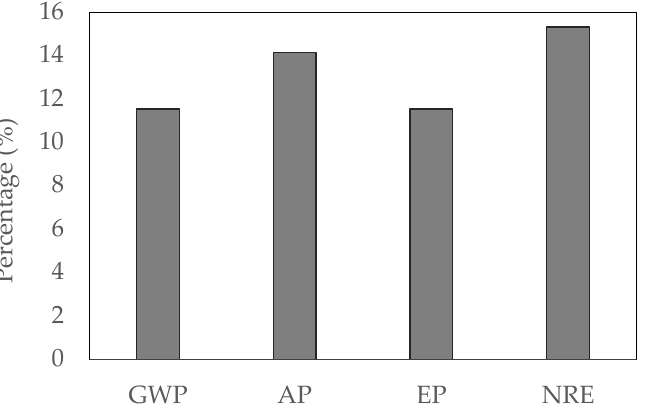
Figure 5. Average possible reductions for GWP (Global Warming Potential), AP (Acidification Potential), EP (Eutrophication Potential), and NRE (Non-Renewable Energy) use for the inefficient DMUs.